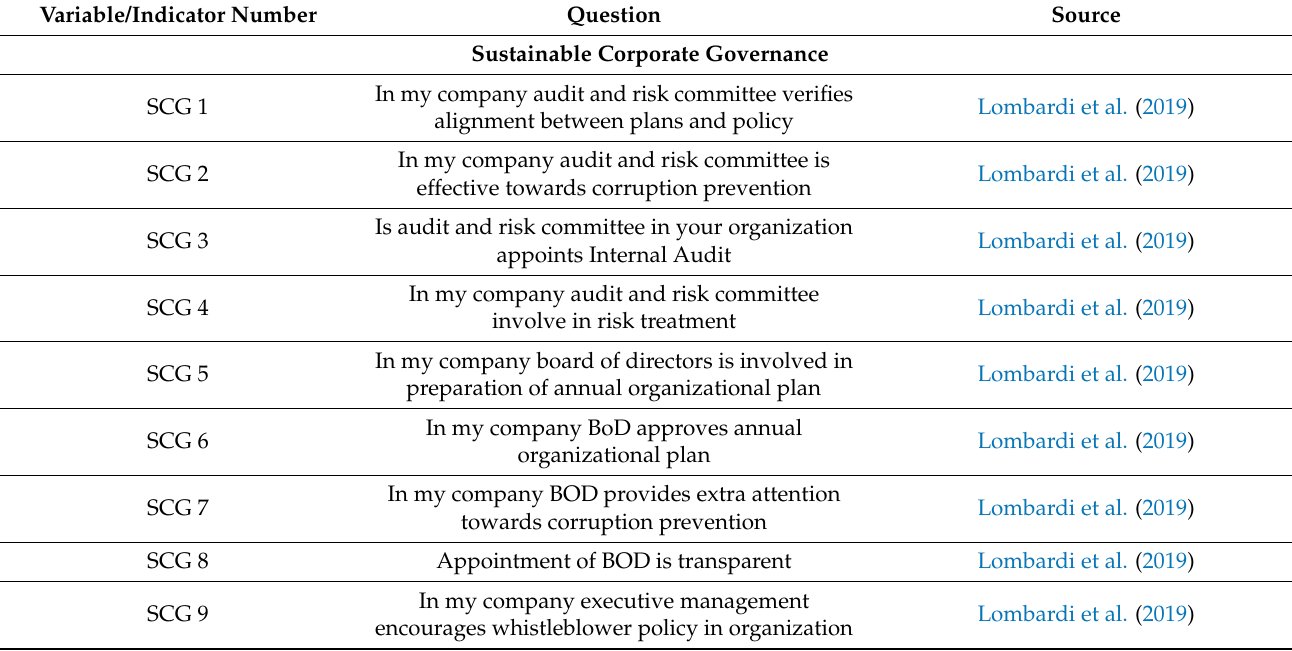
Table A1. Questions for this